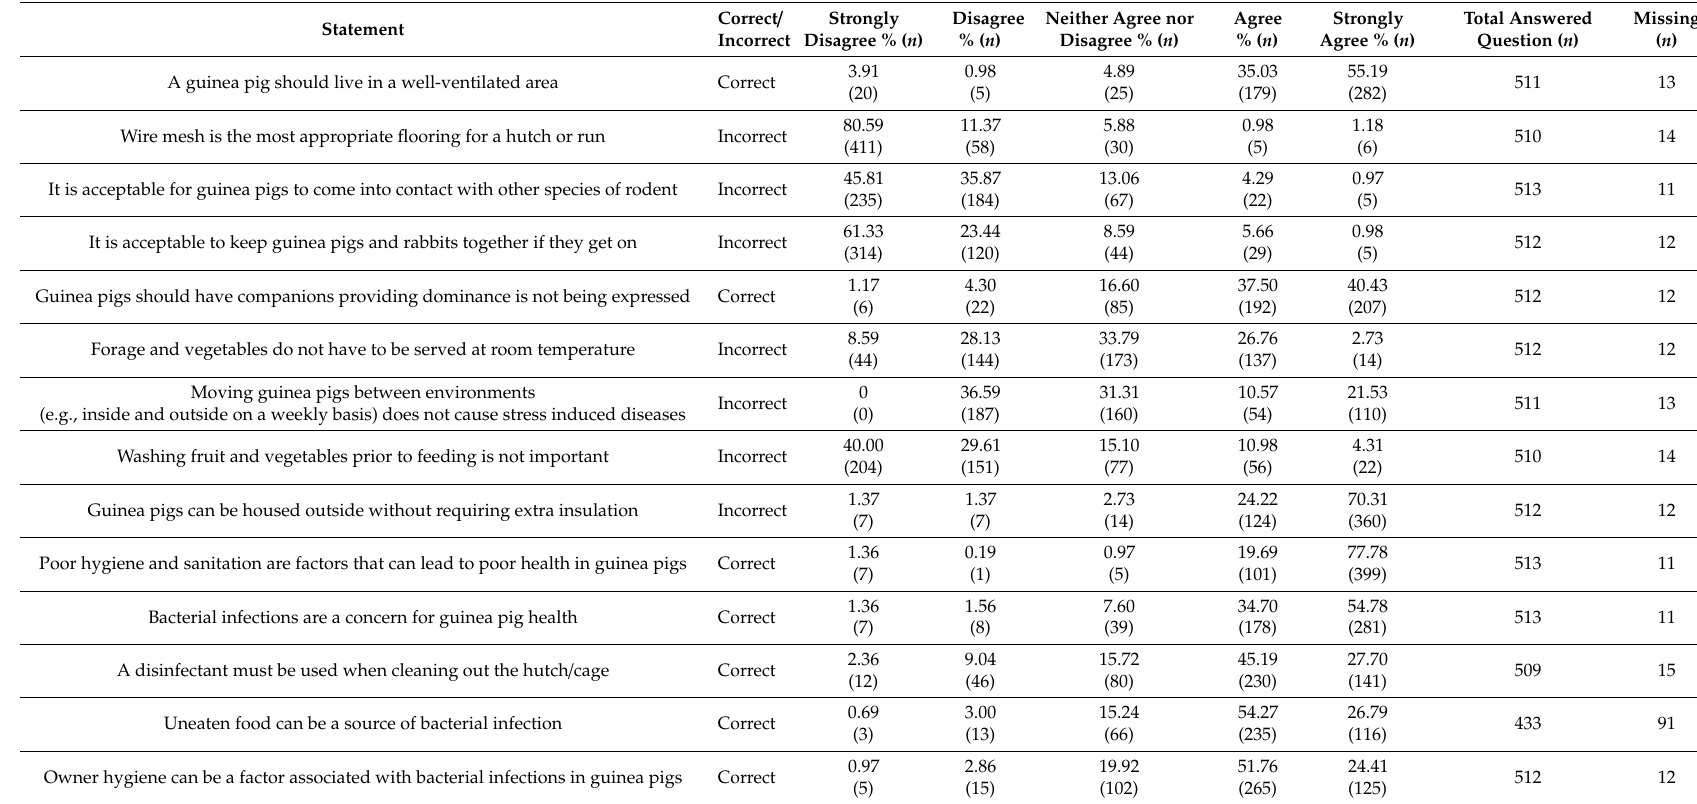
Table 1. Statements on health and husbandry and responses 1